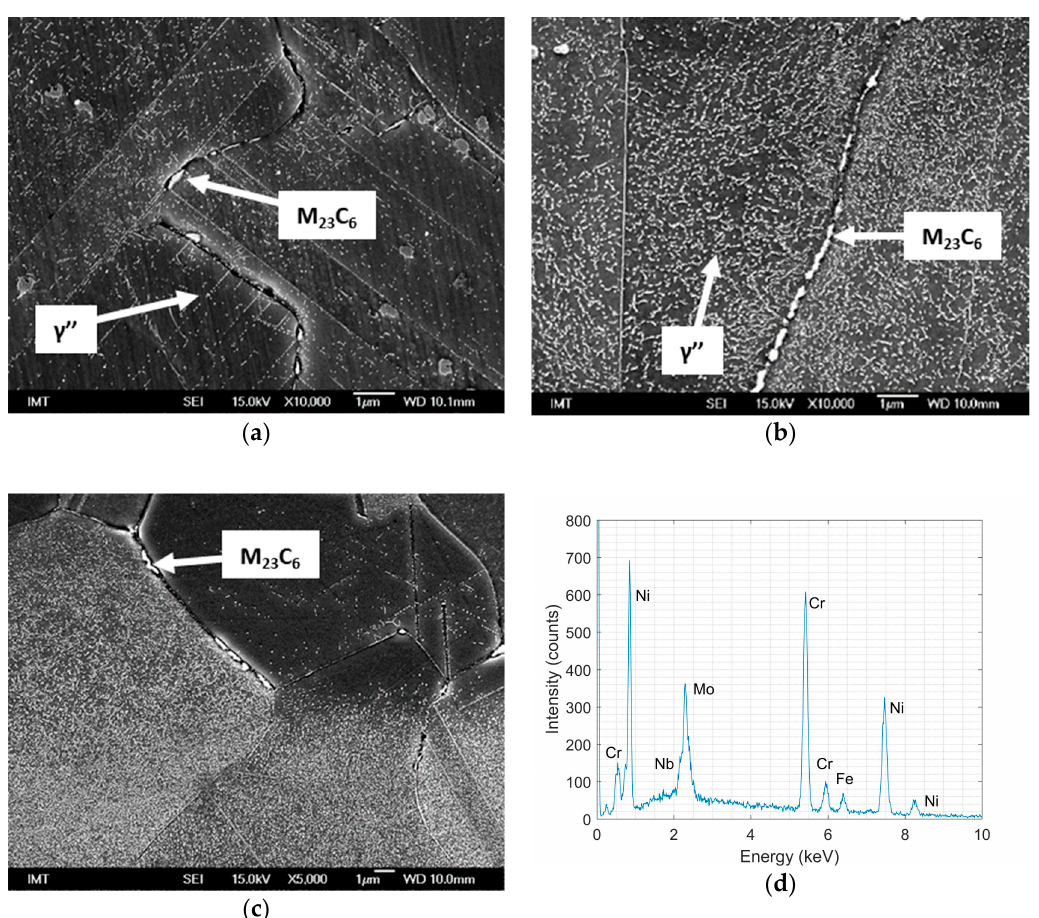
Figure 8. The precipitation of the γ ” in lines in the recrystallized grains of the sample hot rolled at 1050 ◦ C with the deformation level of 23.5% and aged at 750 ◦ C for 1 h ( a ). Secondary M 23 C 6 carbides at the grain boundary in the samples hot rolled at 1150 ◦ C with the deformation level of 5.7% and aged at 750 ◦ C for 5 h ( b ). Precipitation of the secondary M 23 C 6 carbides on the grain boundaries in the sample hot rolled at 1050 ◦ C with the deformation level of 14.4% and aged at 750 ◦ C for 5 h ( c ). The EDS spectrum of the secondary M 23 C 6 carbide in Figure 8c ( d ).